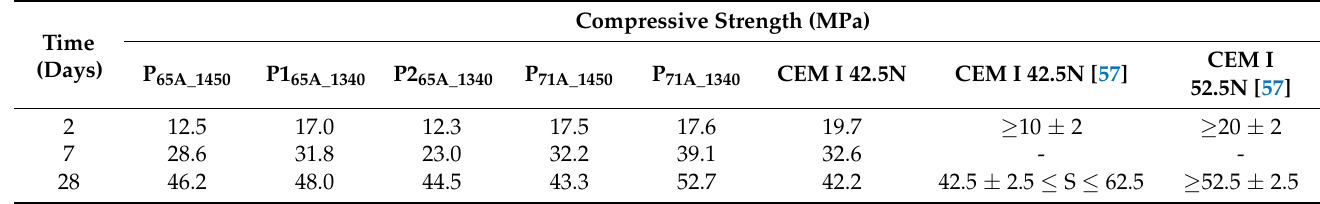
Table 7. Strength results of the produced cement specimens. Characteristic values of CEM I 42.5N and CEM I 52.5N [57] cement classes are also